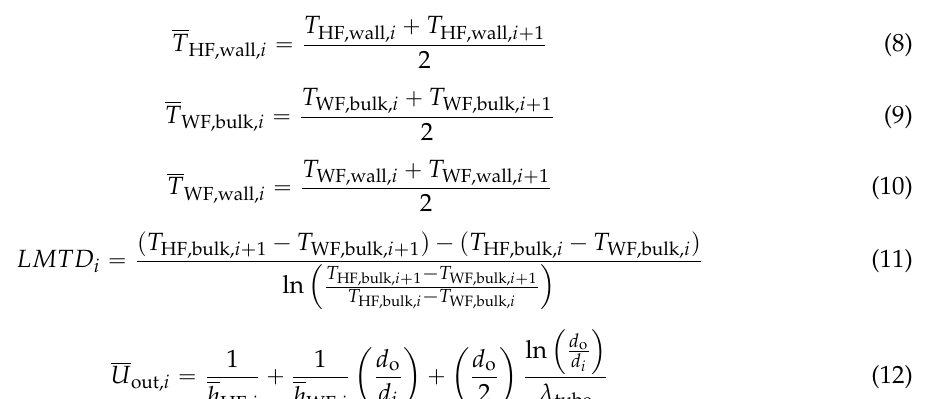
Figure 3. Schematic cut-away view of a helical coil heat exchanger.